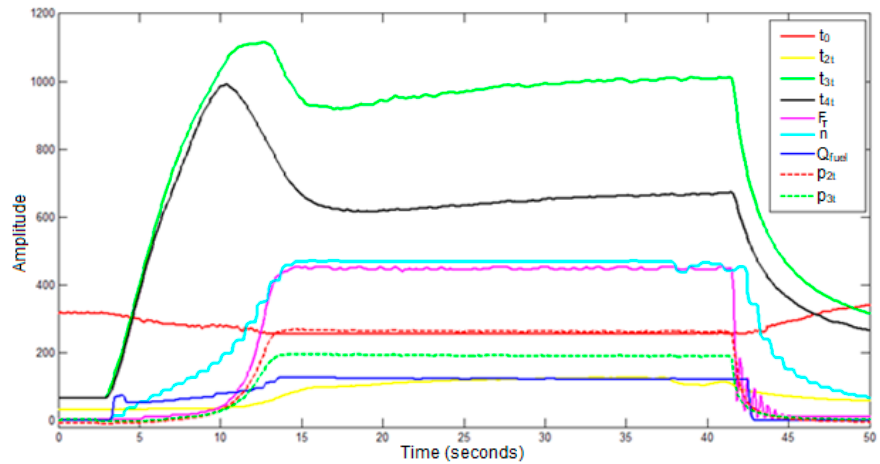
Figure 4. Graphic course of changes in SJE-20 parameters at 100% Jet A-1 aviation kerosene. Table 6. Mixture of 100% Jet A-1 aviation kerosene and 0% FAME biofuel, 1st launch (40th second).